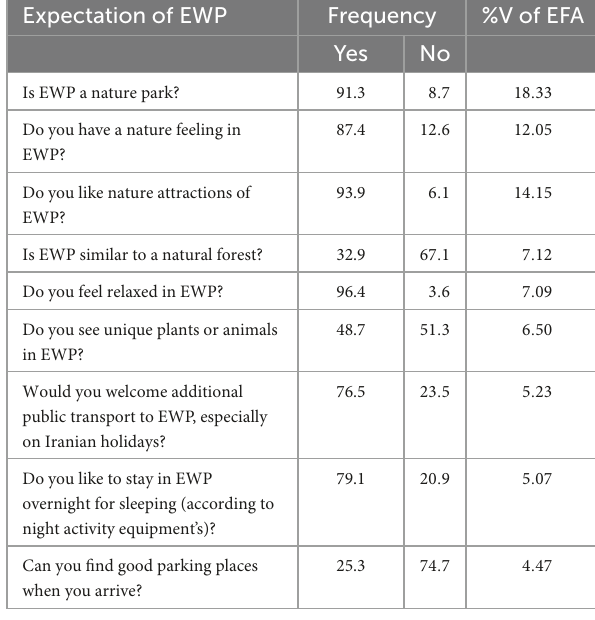
TABLE 3 Visitors’ expectation of EWP.